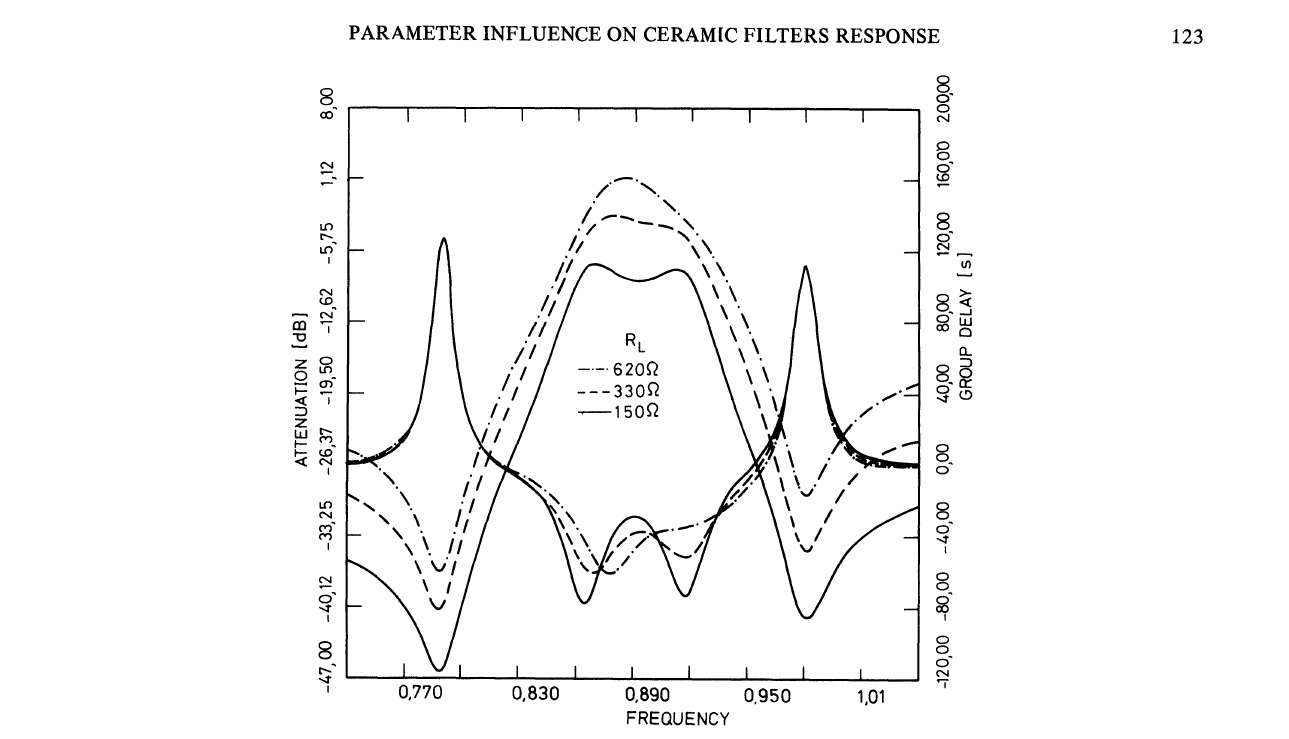
FIGURE 15 Calculated filter responses as the load impedance changes (a correcting factor of 0.25 had to be used for the load admittance value).